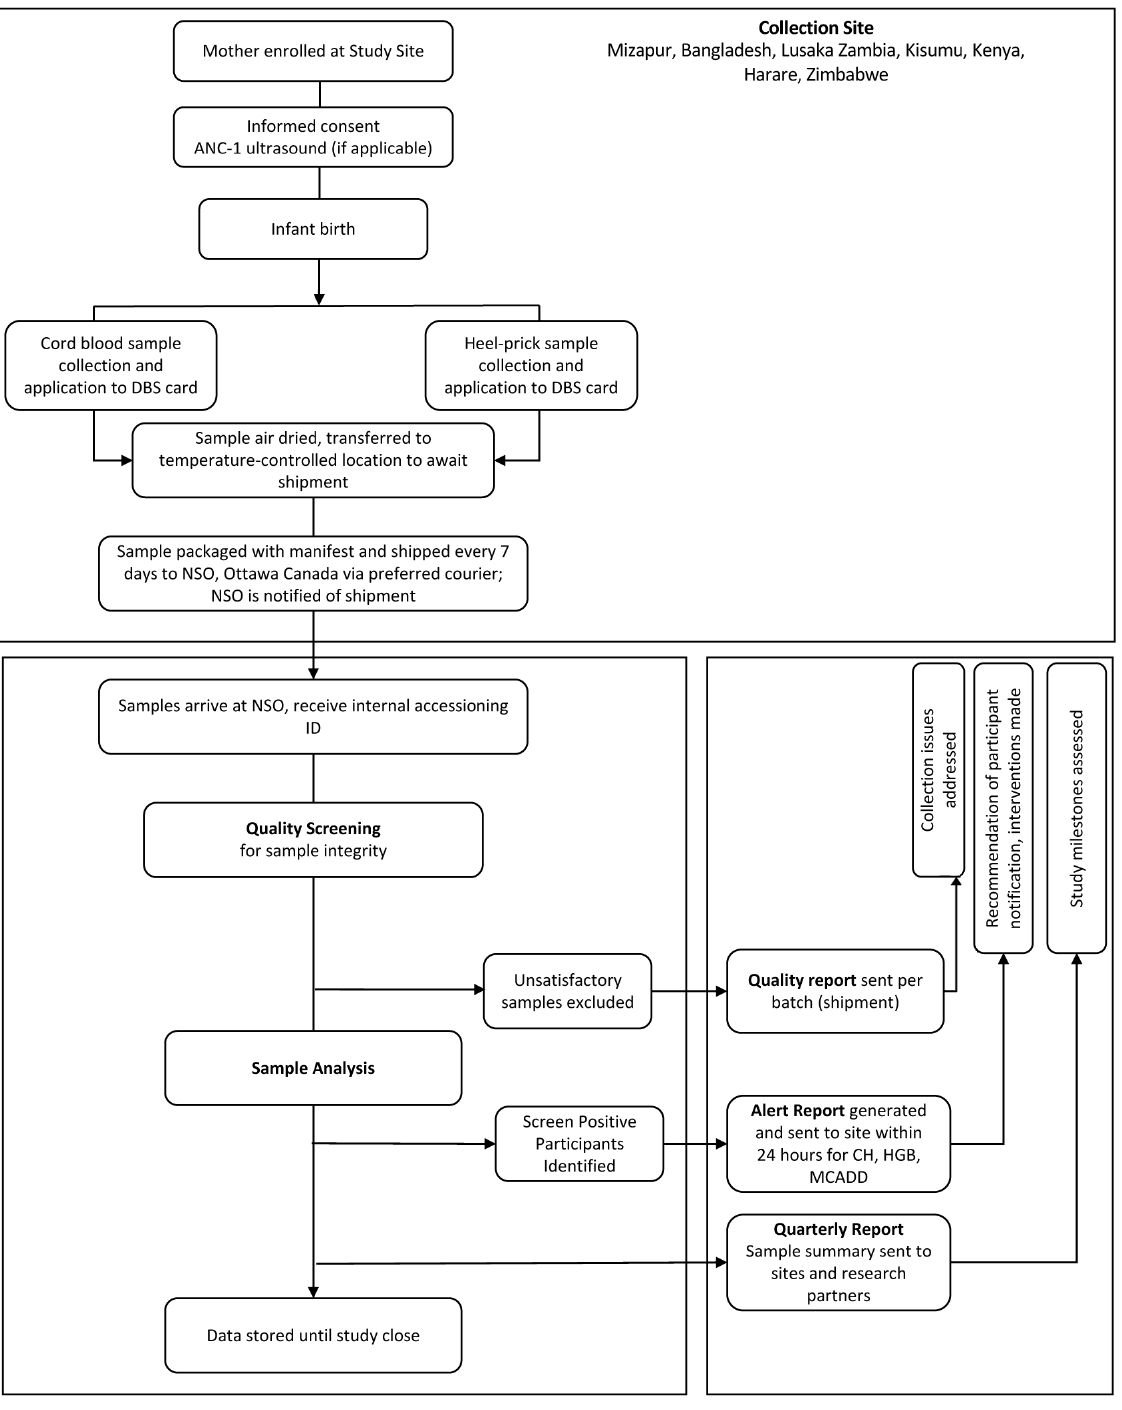
Figure 1. Study Workflow. Participants are enrolled in the research study, and samples collected at the collection sites are sent weekly via preferred courier to Newborn Screening Ontario (NSO), Ontario, Canada for analysis. Reporting procedures from the NSO to the collection site include provision of reports on sample quality, on newborns’ risk of congenital hypothyroidism (CH), medium-chain acyl-CoA dehydrogenase deficiency (MCADD) and haemoglobinopathies (HGBs) and quarterly reports summarizing study progress. Adapted from 12 under a CC BY 4.0 licens e . ANC, antenatal care; DBS, dried blood spot; NSO, Newborn Screening Ontario; CH, congenital hypothyroidism; HGB, hemoglobinopathies; MCADD, medium-chain acyl-CoA dehydrogenase